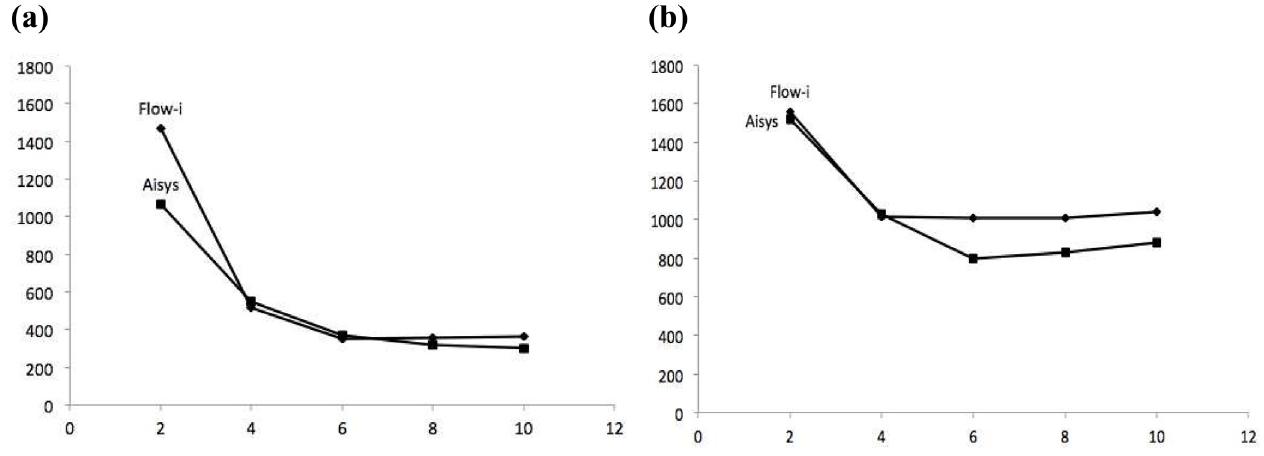
Figure 3. Wash-out times comparing Flow-i and Aisys AMs. ( a ) sevoflurane ( b ) desflurane. Time (s) is on the Y-axis and FGF (l/min) is on the